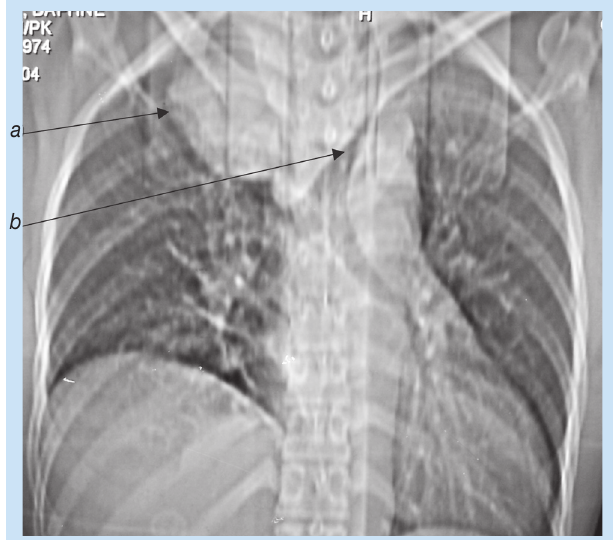
Fig. 8. Frontal chest radiograph: (a) right superior mediastinal mass with (b) narrowing and displacement of the trachea to the left.